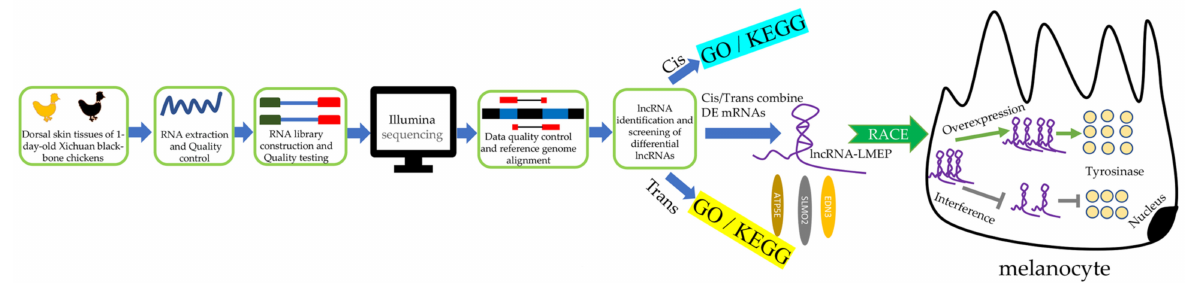
Figure 1. Flow chart for screening and functional validation of lncRNA- LMEP . In this article, we screened the core lncRNA-LMEP by transcriptome sequencing and validated its biological function. We found that lncRNA-LMEP may promote tyrosinase content through the ATP5E , SLMO2 and EDN3 genes to promote melanin deposition in chicken